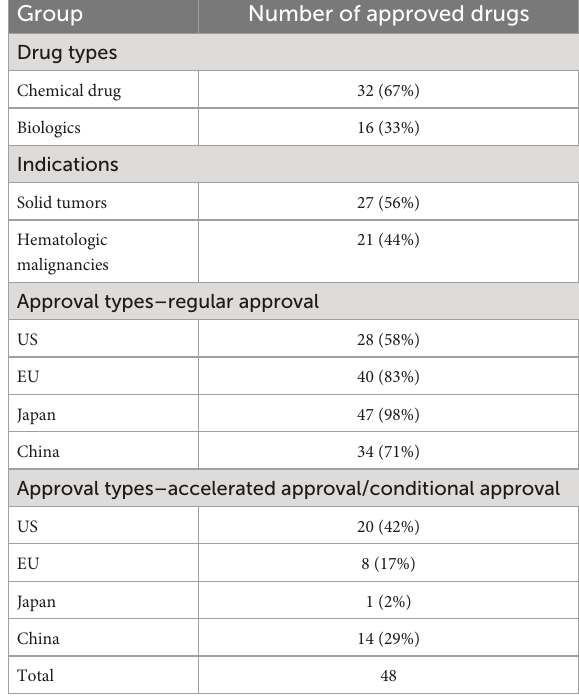
TABLE 4 Characteristics of approved